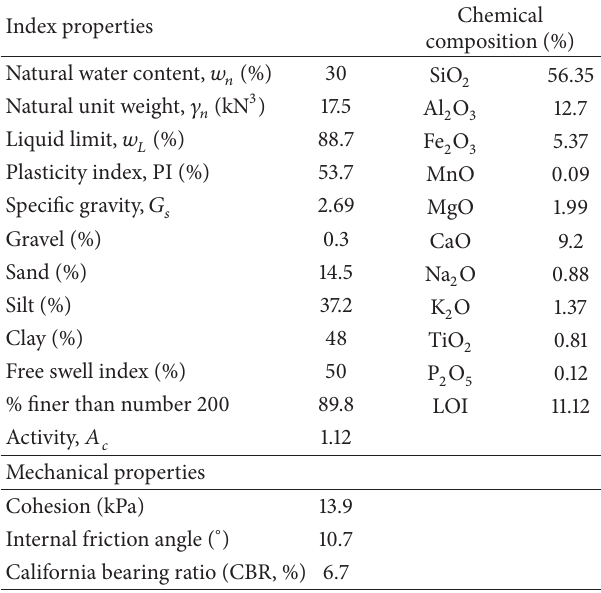
Table 1: The physicomechanical properties and the chemical com- position of